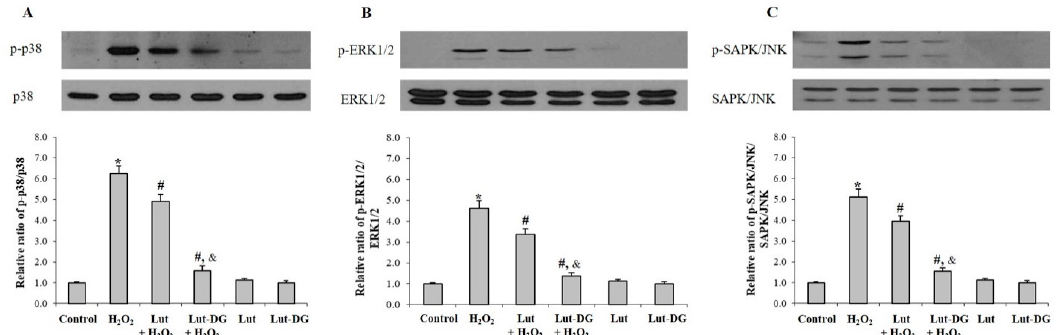
Figure 5. Protective effects of Lut and Lut-DG against oxidative stress occurs through modulation of the apoptotic MAPKs signaling pathway. ARPE-19 cells were pre-incubated with 1 µ M of Lut and Lut-DG for 24 h, followed by H 2 O 2 treatment at 400 µ M for 1 h. Protein levels of phosphorylated ( A ) p38, ( B ) ERK1/2 and ( C ) SAPK/JNK were determined by immunoblotting of cell lysates. Band densitometry values of p-p38, p-ERK1/2 and p-SAPK/JNK were normalized to the band of p38, ERK1/2, and SAPK/JNK, respectively. Representative western blots are shown, with graphs presenting average normalized protein expression. Results are presented as mean ± SD values, n = 4; (One-Way ANOVA test), * p ≤ 0.05 vs. control group, # p ≤ 0.05 vs. H 2 O 2 group, and & p ≤ 0.05 vs. Lut + H 2 O 2